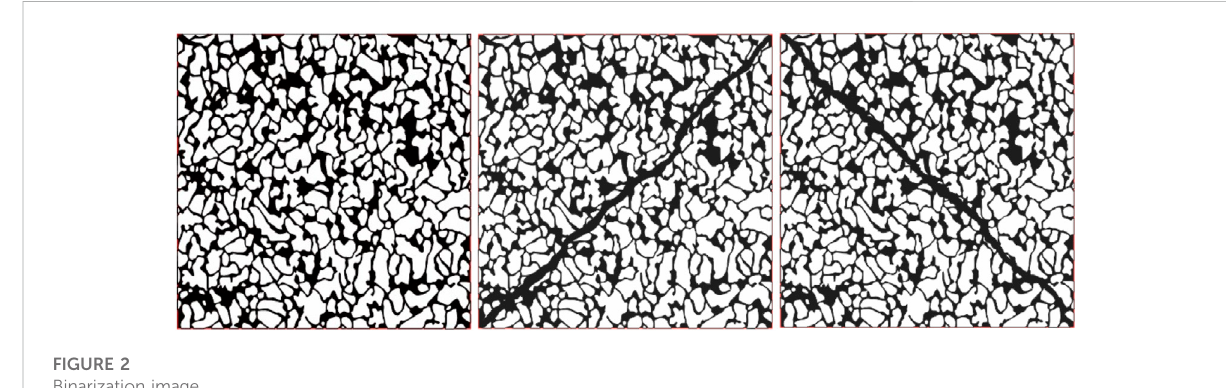
FIGURE 2 Binarization